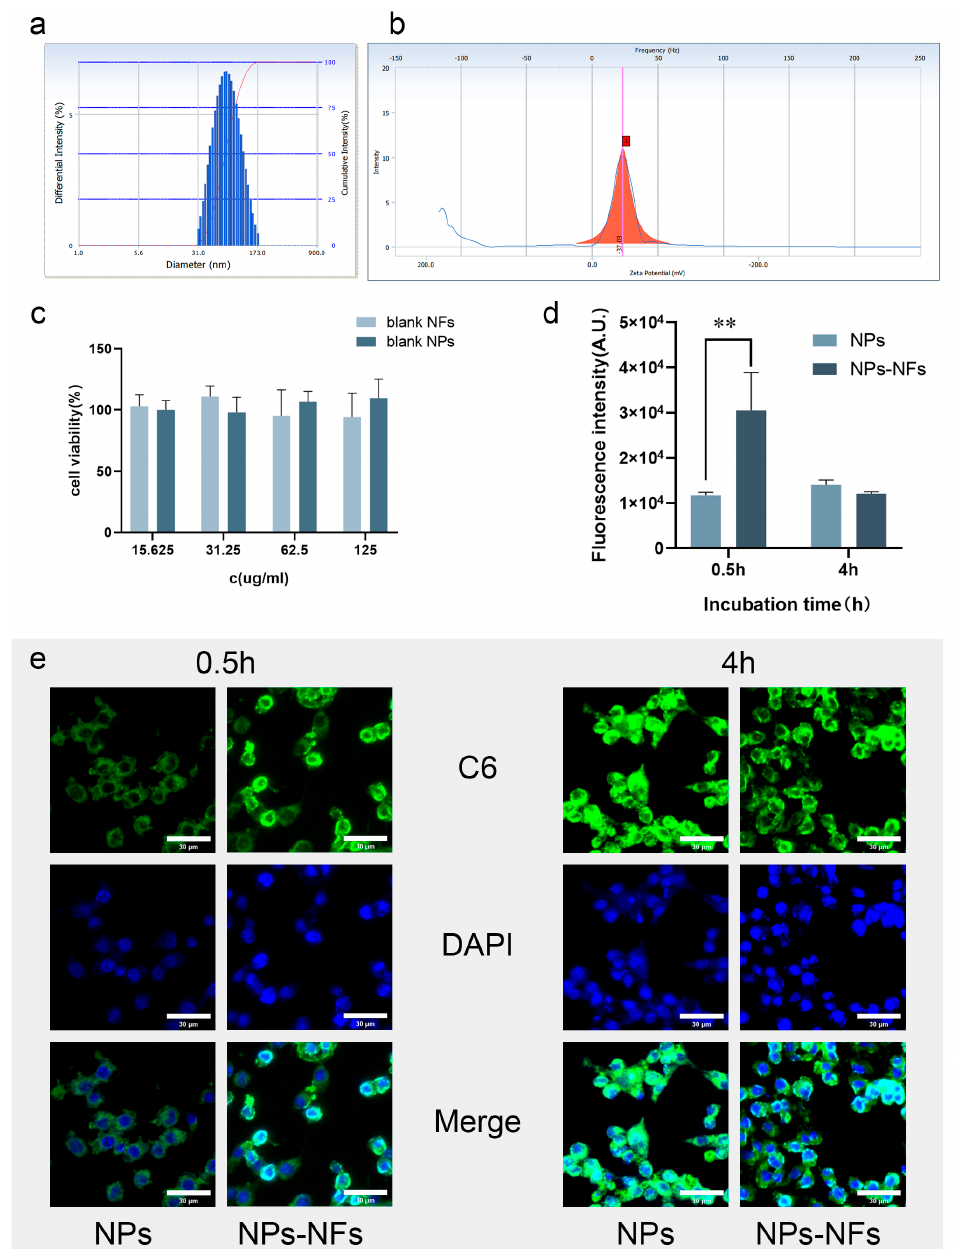
Figure 6. Uptake of RAW264.7 cells by fluorescence confocal microscopy and flow cytometry; ( a ) Particle size distribution of C6-NPs; ( b ) Potential distribution of C6-NPs (The red square on the x-axis is the potential value.); ( c ) Cytotoxicity study of blank preparation CCK8; ( d ) Fluorescence uptake analysis of flow cytometry at 0.5 h (** means p < 0.01) and 4 h; ( e ) Observation of cell uptake at 0.5 h and 4 h under confocal fluorescence (scale: 30 μ m); C6 green fluorescence indicates the state of uptake instead of the model drug as a probe. The DAPI-stained nuclei are blue. Merge indicates the whole uptake state.